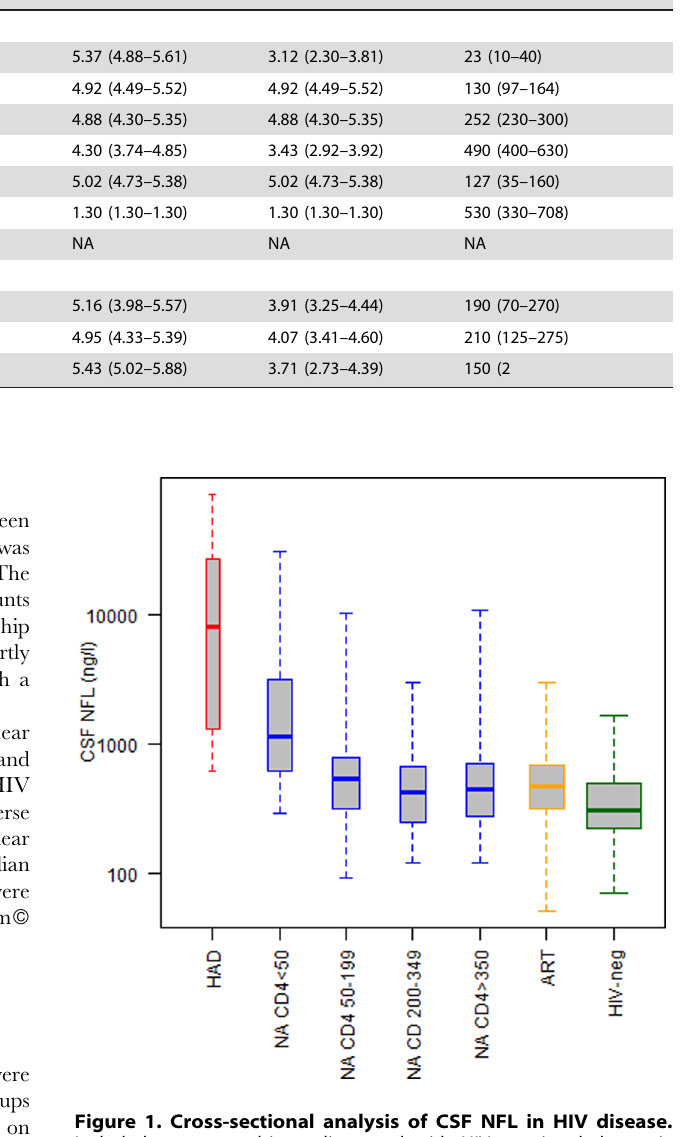
Figure 1. Cross-sectional analysis of CSF NFL in HIV disease. Included were 14 subjects diagnosed with HIV-associated dementia (HAD); HIV positive neuroasymptomatic subjects (NA) without antiret- roviral treatment stratified according to levels of blood CD4 T-cells , 50 (n=42), 50–199 (n=49), 200–349 (n=52) and . 350 (n=57); 85 subjects on combination antiretroviral treatment (ART) for at least one year and plasma HIV-RNA , 50 copies/ml and 204 HIV seronegative volunteers (HIV-neg). CSF NFL concentrations were higher in patients with HAD compared to all other groups. Elevated levels of CSF NFL was also found in subjects with a CD4 + T-cell count below 50 cells/mL compared to groups in higher CD4 + T-cell count strata. Whiskers represent full range